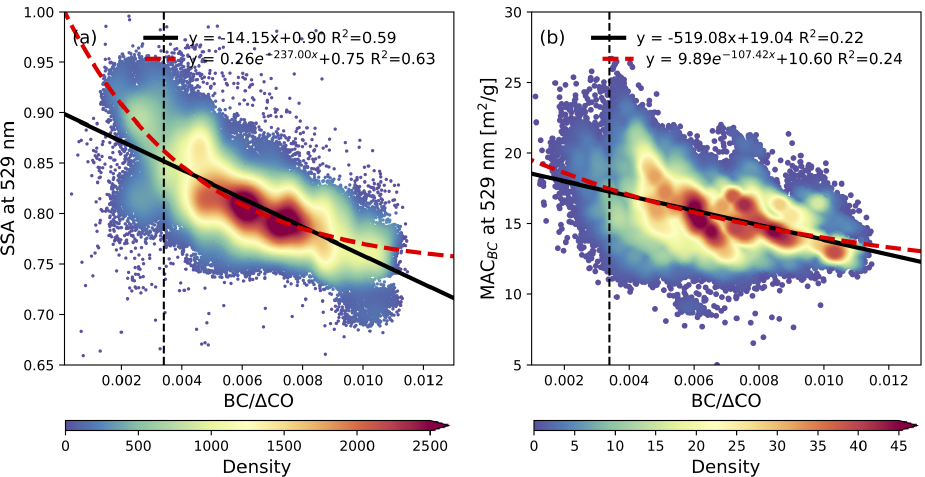
Figure 4. Relations of BC /(cid:49) CO with (a) SSA and (b) MAC BC at 529nm wavelength. The solid black lines represent the linear regressions, and the dashed red lines are the curve fitting with the function displayed in the legend. The colour scale indicates the density of the data in each plot. The vertical dashed black lines in each plot correspond to BC /(cid:49) CO = 0.0034.